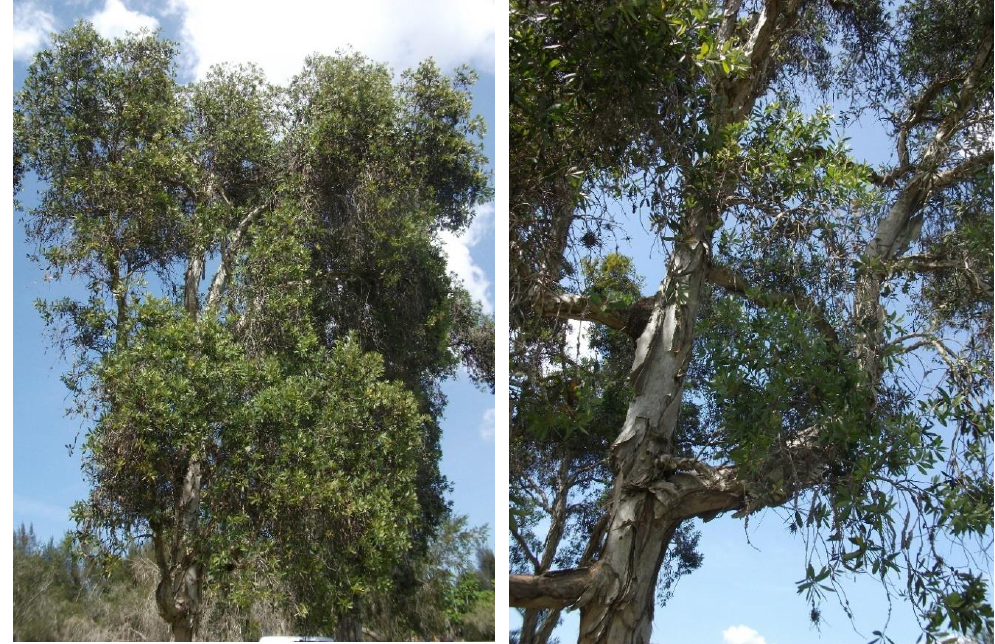
Figure 1. Photographs of Melaleuca leucadendra plant cultivated in National Botanic Garden, Havana, Cuba (Picture taken by the authors during the collection of the plant).